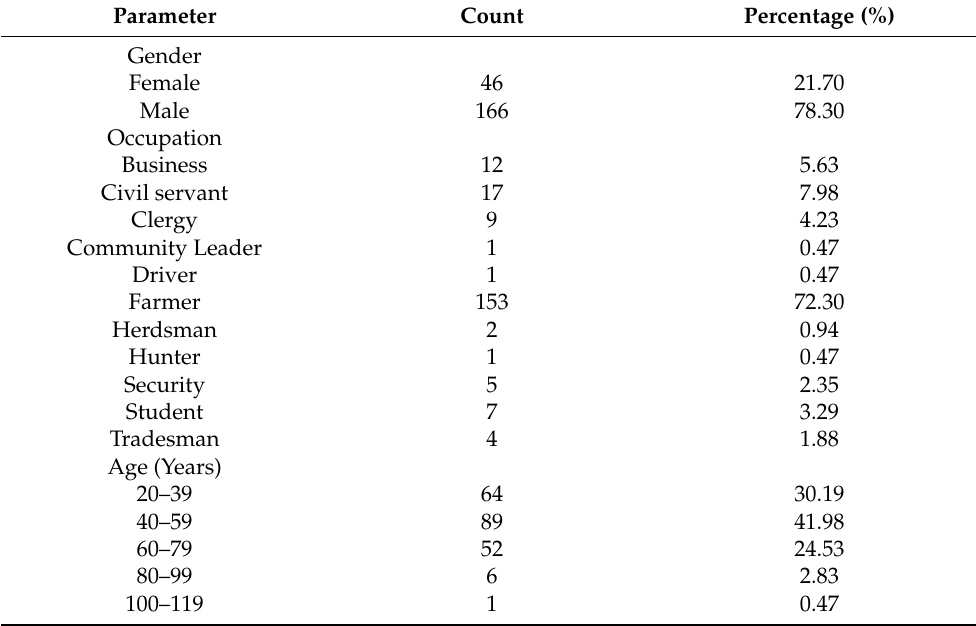
Table 1. Statistics on the usage of plants as pesticides in Plateau State,